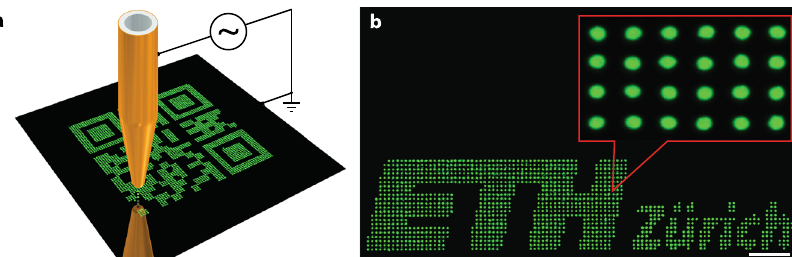
Fig. 3 EHD printing. a Scheme representing the EHD printing setup used to print the colloidal perovskite CsPbBr 3 NC inks. A voltage is applied between a gold-coated capillary nozzle and a grounded substrate, which drives the EHD ejection of ink droplets. b An example of the high-resolution printed pattern (~12,000dpi) showing low dot-to-dot variation, the distance between dots is 2 µ m, the scale bar is 20 µ m.